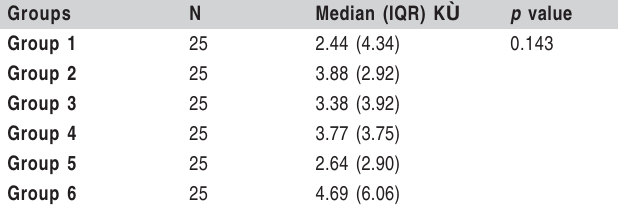
Table 1. Comparison of microleakage values among the groups after 20 months of evaluation (Kruskal-Wallis test).